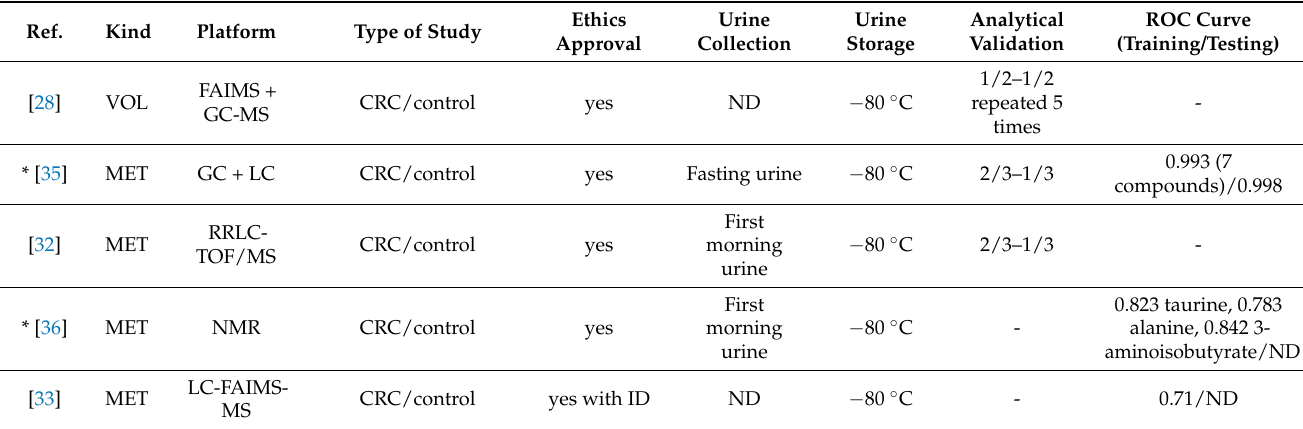
Table 1. Methodological information from the systematic review (qualitative analysis) of selected studies. Asterisk * indicates that the study was used in the meta-analysis (quantitative analysis). Studies are ordered by type and then by reference.